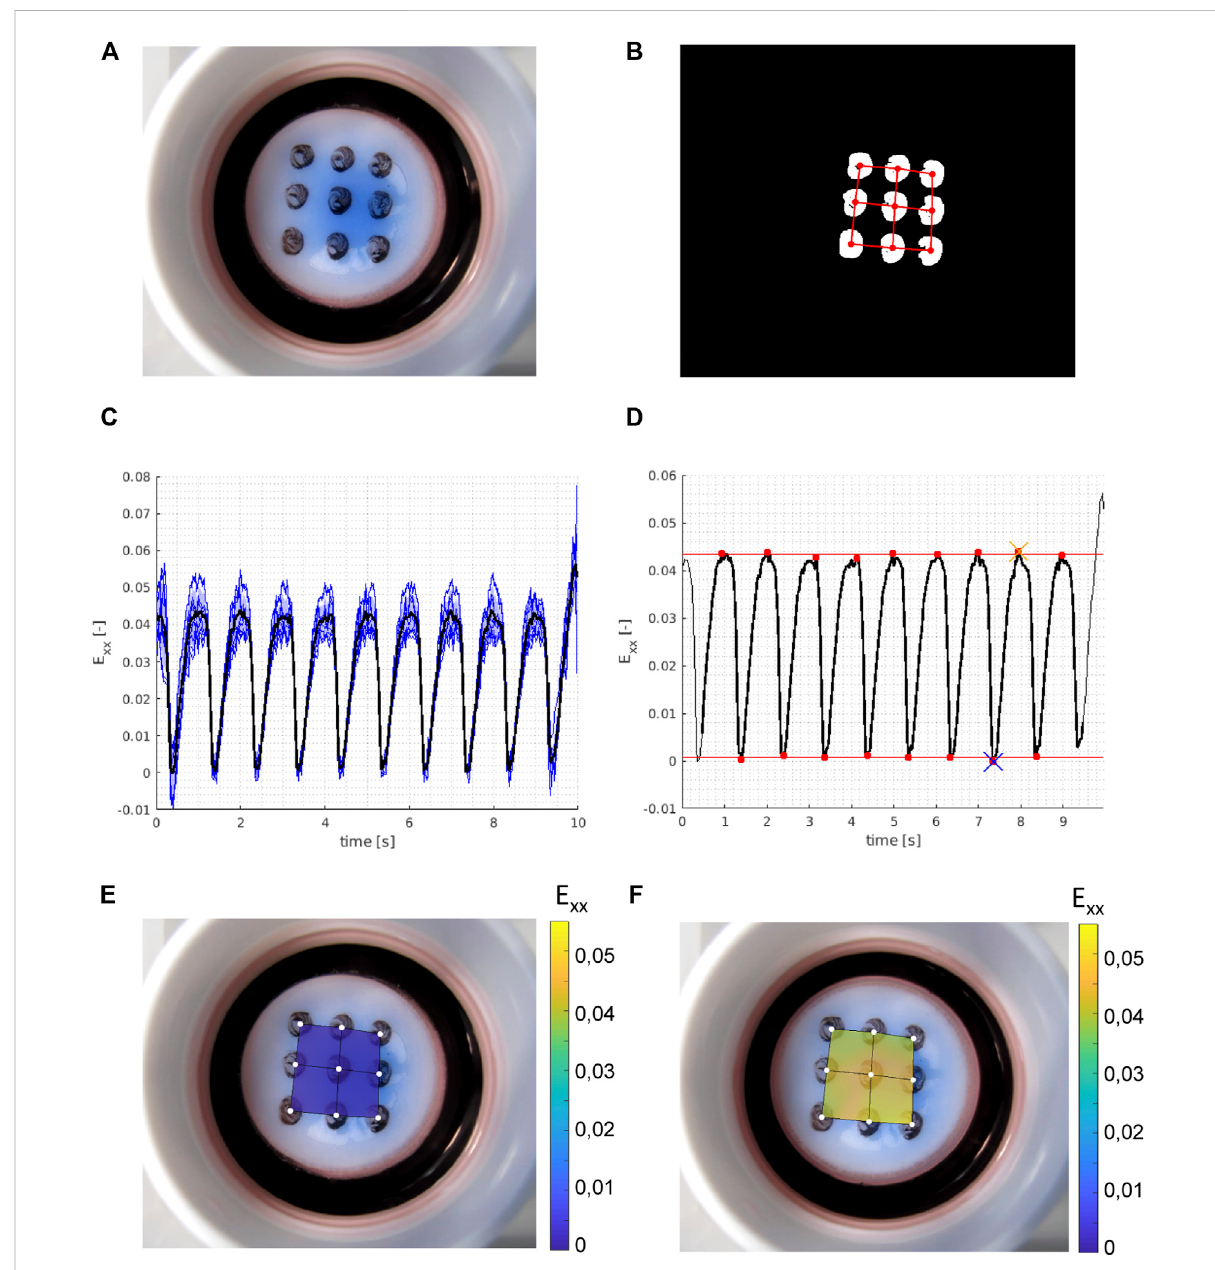
FIGURE 1 Example of experimental strain analysis. With (A) a raw (RGB) frame from the movie showing the Bio fl ex plate and the dot pattern; (B) binary frame after image pre-processing with the isolated grid dots and with the fi nite element mesh super-imposed in red; (C) calculated (horizontal) strains(E xx )inallninegriddotsovertime(blue,thin)withthemeanstrain(black,thick)overtime; (D) peakanalysisonthetimeaveragedstrains(black, thick) from (C) with the identi fi ed peaks and valleys (red dots), and the mean valley strains (bottom red line) and mean peak strains (top red line) which give us thecalculated horizontal strainamplitudeofthesample.Thebluecross showsthereferenceframefor thevalley strain visualized in (E) and the orange cross shows the reference frame for the peak strain visualized in (F) . Vertical strain amplitudes are calculated with the same method, and the average of horizontal and vertical strain amplitudes is taken as the approximate equibiaxial strain level of the sample.